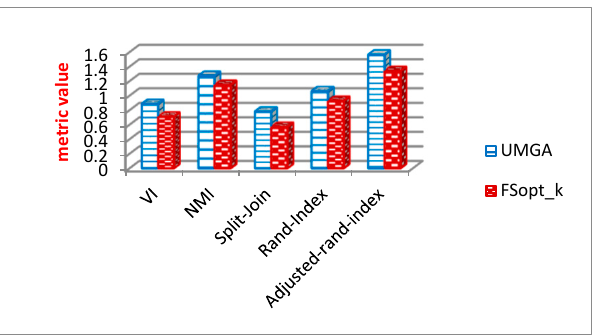
Figure 17. Average of the normalized values for each metric on all datasets .